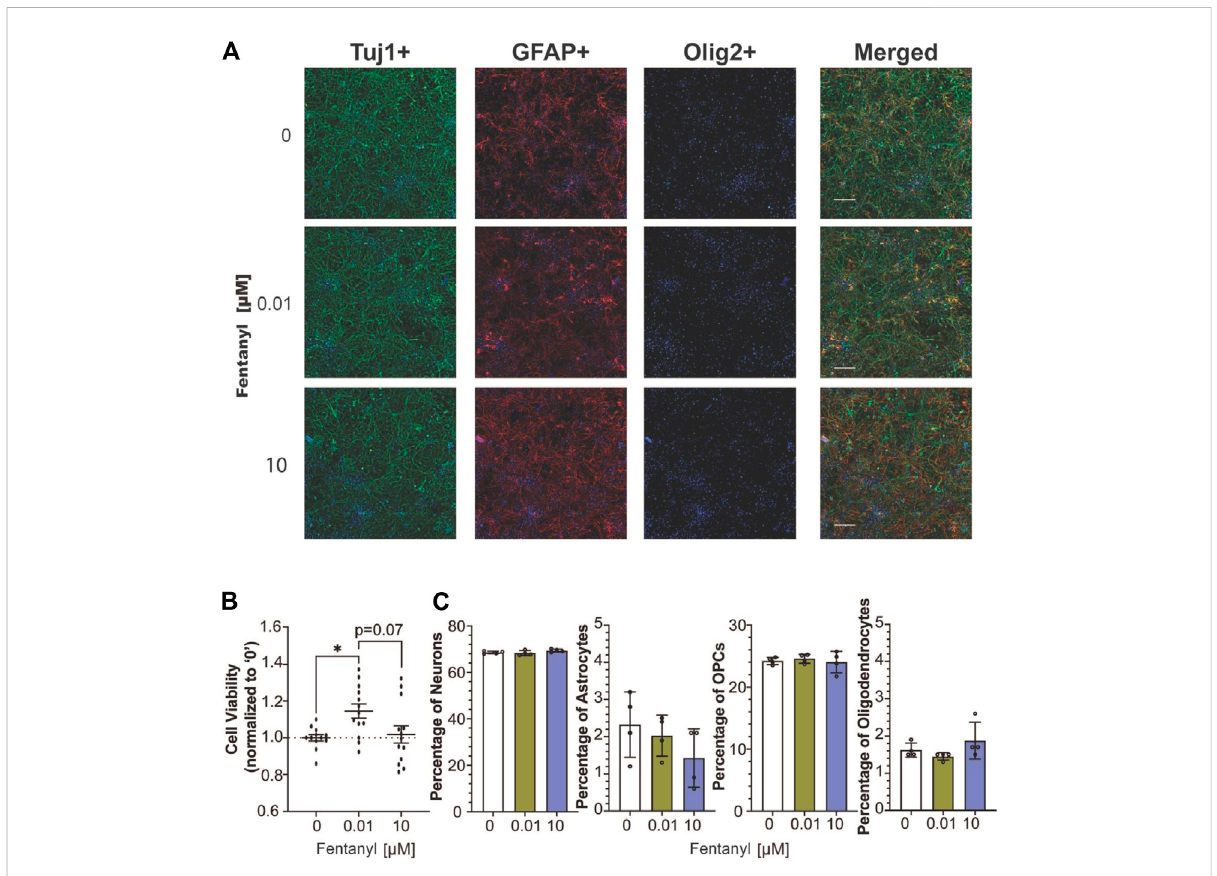
FIGURE 3 Cell viability of complex culture containing neurons, astrocytes, and oligodendrocyte precursor cells after 96 h of exposure to fentanyl. (A) Representative images of Tuj1-, GFAP-, Olig2- stained cells co-stained with the nuclear marker, DAPI (blue), and merged image of all three cellular markers. (B) Scatter plot summarizes the amount of LDH released in the supernatant of fentanyl-treated cultures ( n = 4 biological replicates with 3 technical replicates) normalized to the untreated (control) condition (e.g., 0 μ M, dotted line). (C) Bar graph summarizes the estimated percentage of neurons, astrocytes, OPCs, and oligodendrocytes in the complex culture nuclear count ( n = 4 biological replicates). Data is shown as mean ± SEM and was analyzed using one-way ANOVA with Tukey ’ s post hoc test. Statistical signi fi cances are observed at a level of * p <